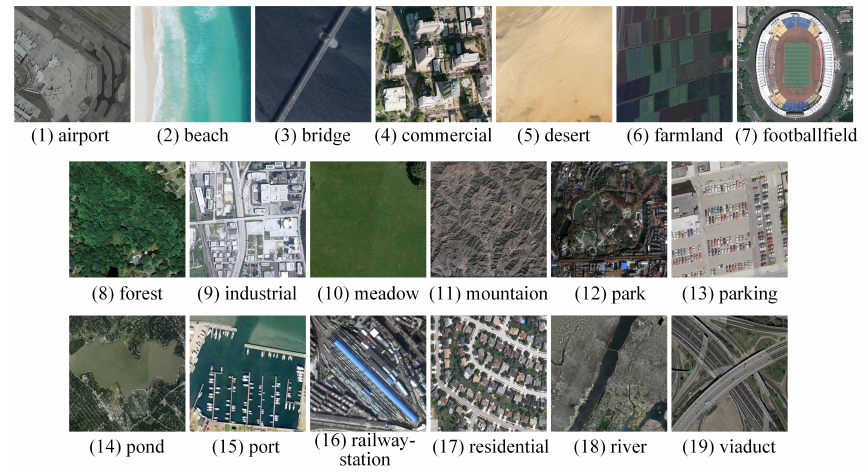
Figure 8. WHU-RS19 dataset, the size of each scene image is 600 × 600, the resolution of images in this dataset is 0.5 m, and the 19 classes of this dataset include airport, beach, bridge, commercial area, desert, farmland, football field, forest, industrial area, meadow, mountain, park, parking lot, pond, port, railway station, residential area, river, and viaduct.